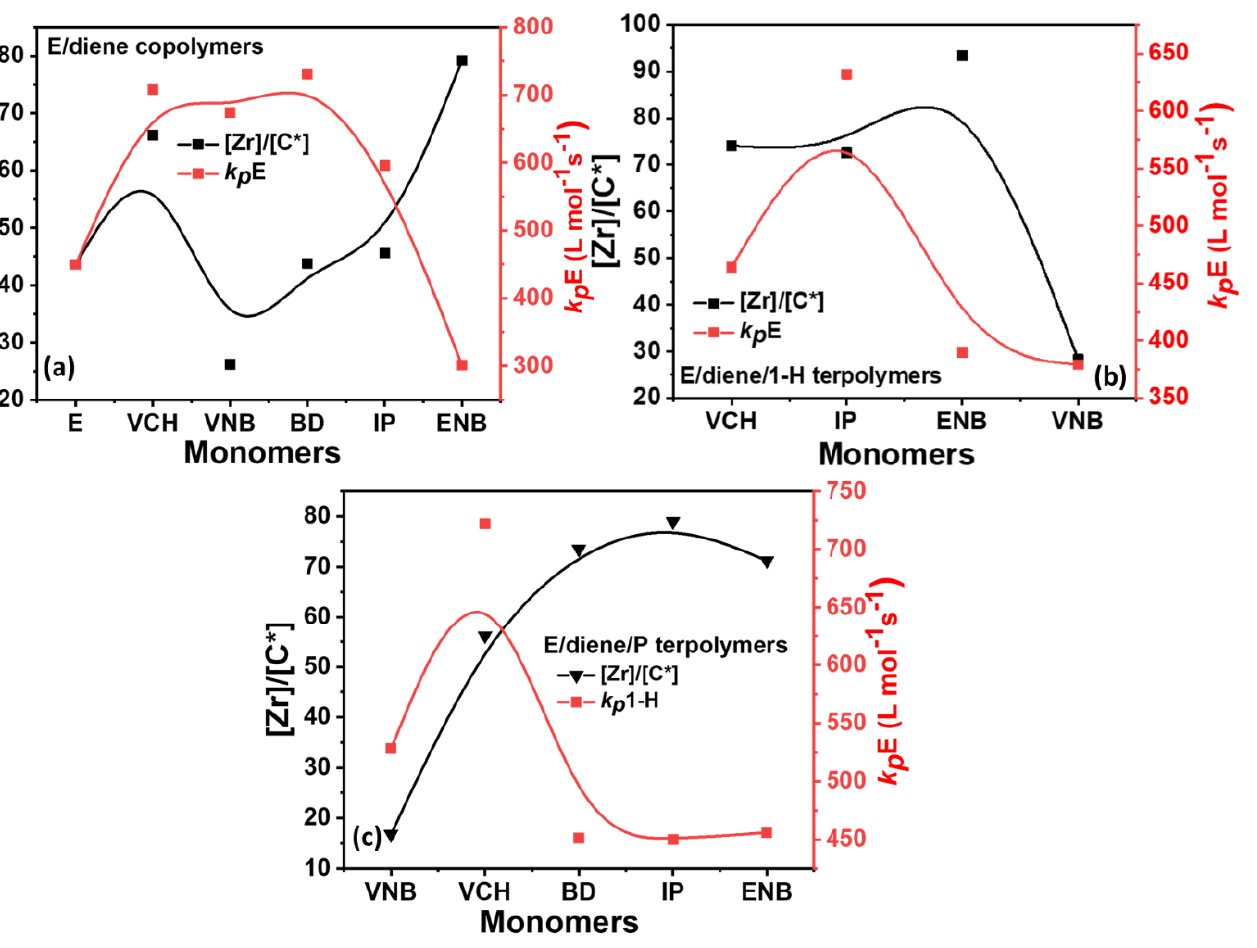
Figure 7. ( a ) relationships between active center and k p E in E/diene, while ( b , c ) are relationships between active center and k p E in E/diene/1-hexene and E/diene/propylene polymerizations, respectively.